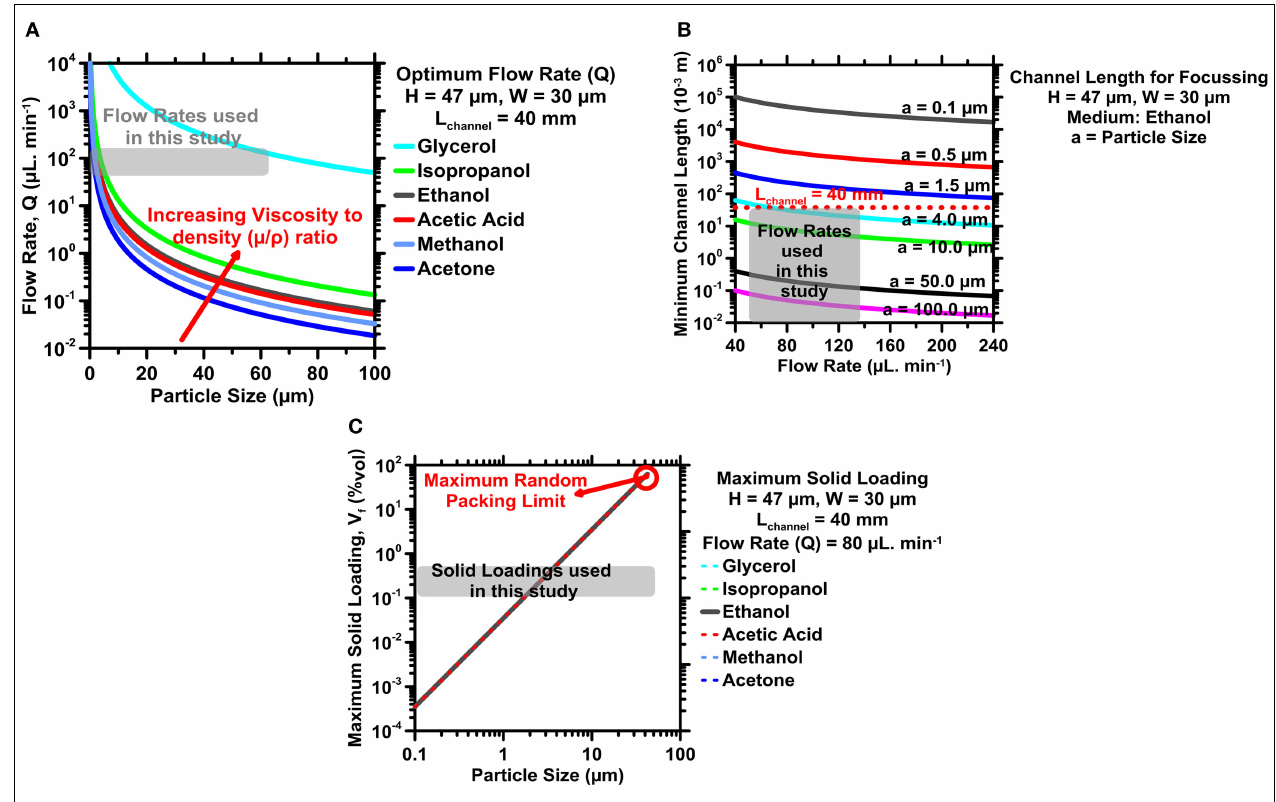
percentage of solids in suspension to limit steric effects as a function of particle size ( a P ). The gray regions indicate optimum ranges selected in operating variables for size-based particle fractionation in this